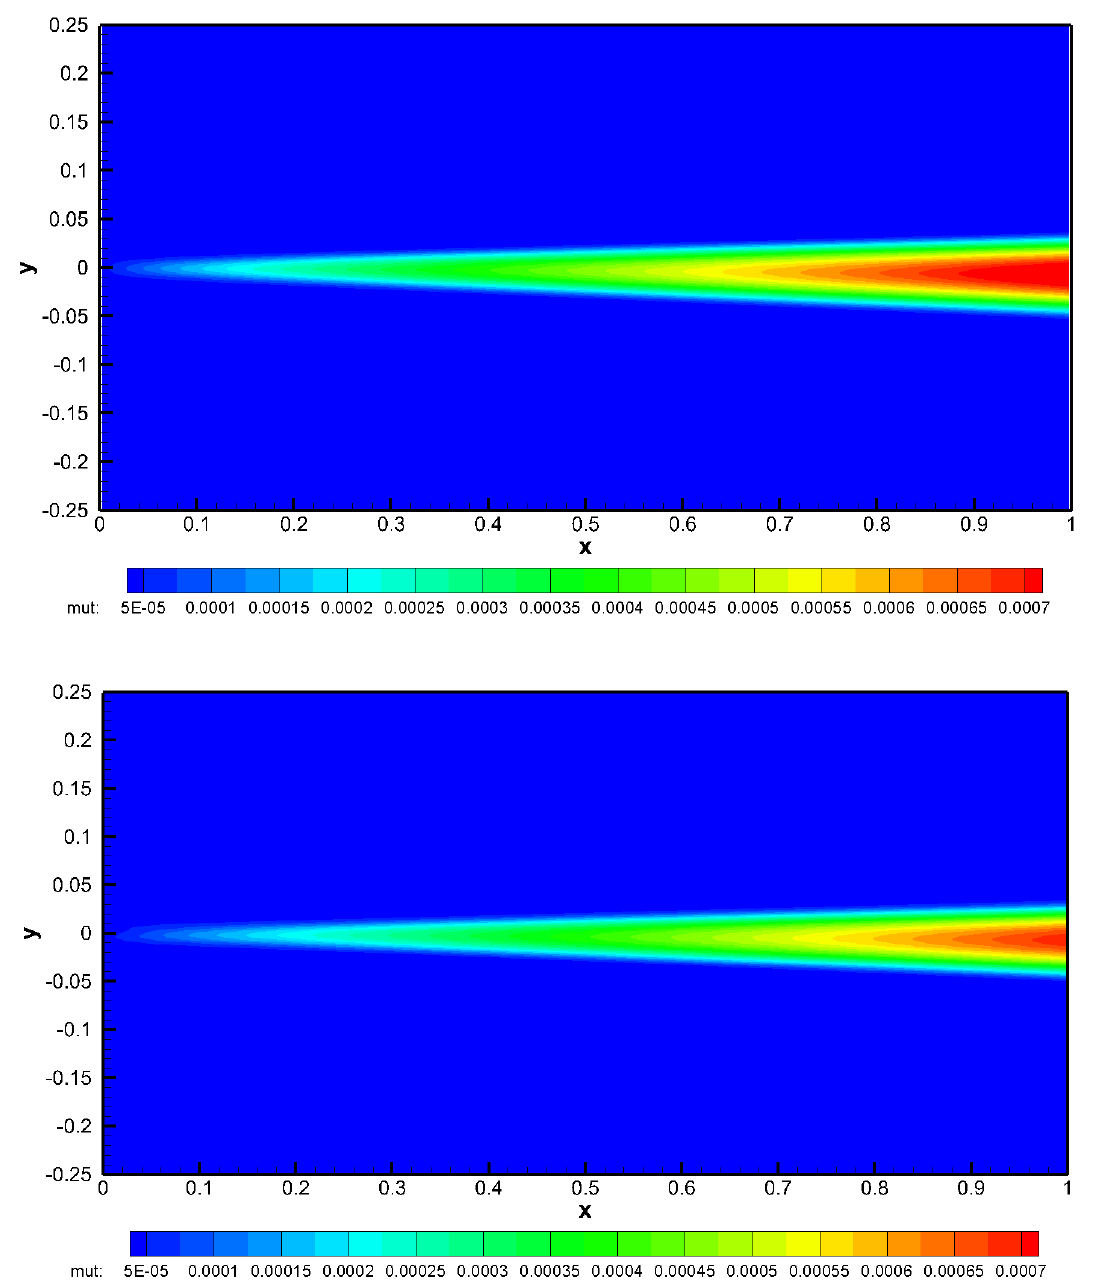
Figure 13. Contour colors of the turbulent viscosity µ t for the 2D planar mixing layer at time t = 10. Cartesian hybrid FV/FE scheme ( top ) and unstructured hybrid FV/FE scheme ( bottom